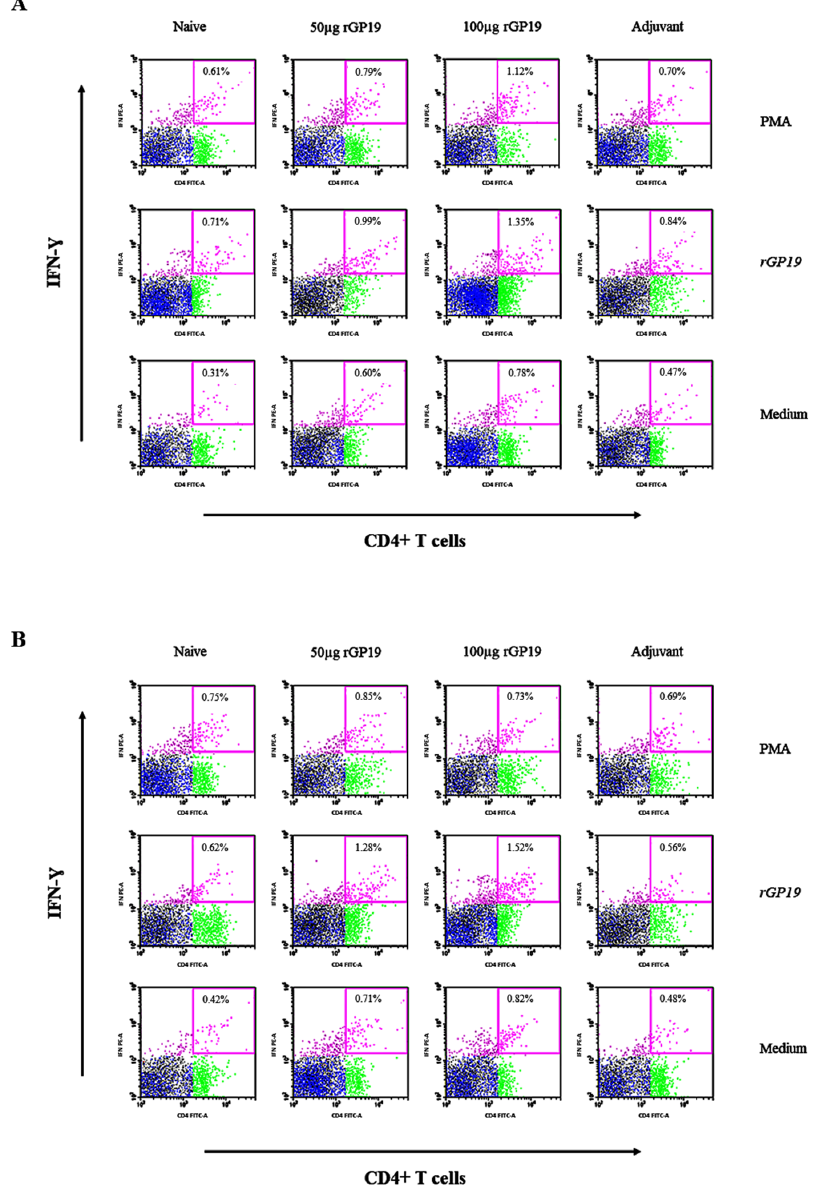
Figure 5. Ehrlichia canis GP19-specific IFN- γ -producing CD4+ T cells develop during E. canis infection in mouse splenocyte determined by flow cytometry. Naive and immunized mice infected with E. canis over a period of 7 days ( A ) and 14 days ( B ) post-infection. The data plot represents the populations of lymphocytes (black dot), CD3+ T lymphocytes (blue dot), CD4+ T lymphocytes (green dot), and IFN- γ molecules in CD4+ T lymphocytes (pink dot).